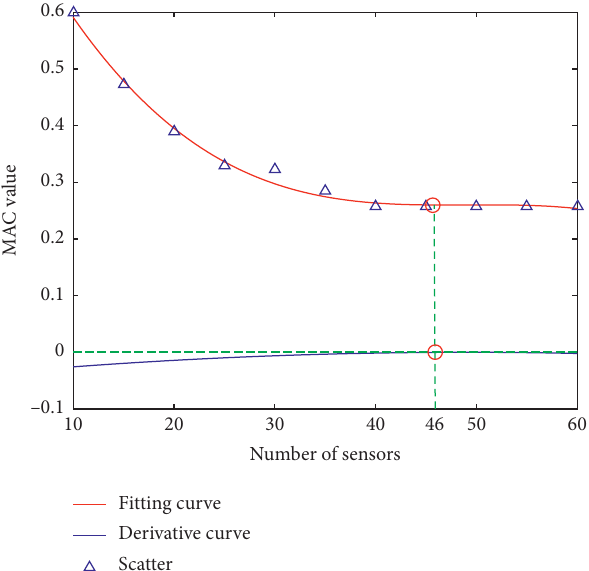
Figure 9: Scatter diagram and the fitting curve when the MAC value changes with the number of sensors.